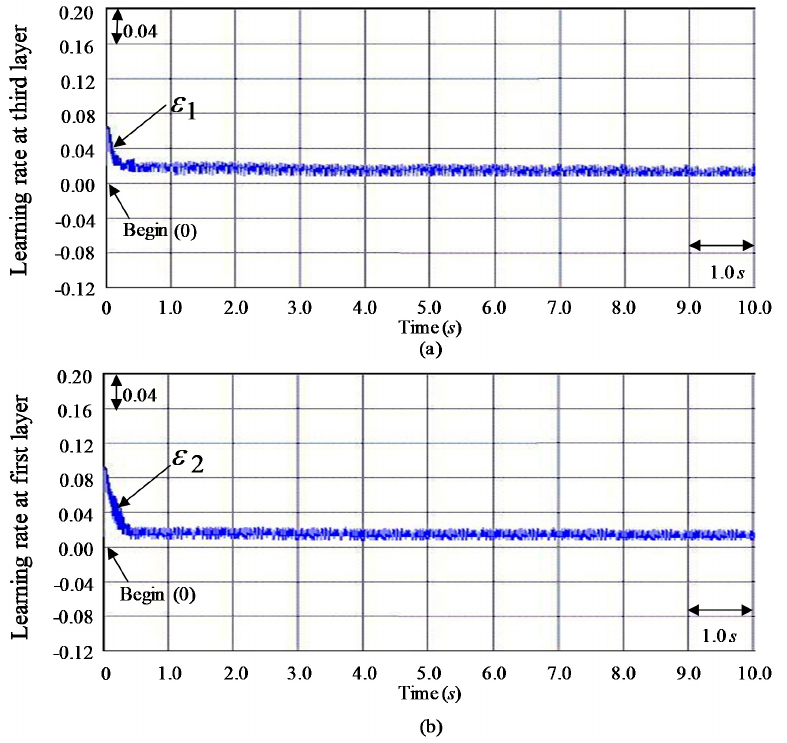
Figure 16. Tested results at the tested Event E2 case by using the controller CT3: ( a ) the convergent response of learning rate ε 1 , ( b ) the convergent response of learning rate ε 2